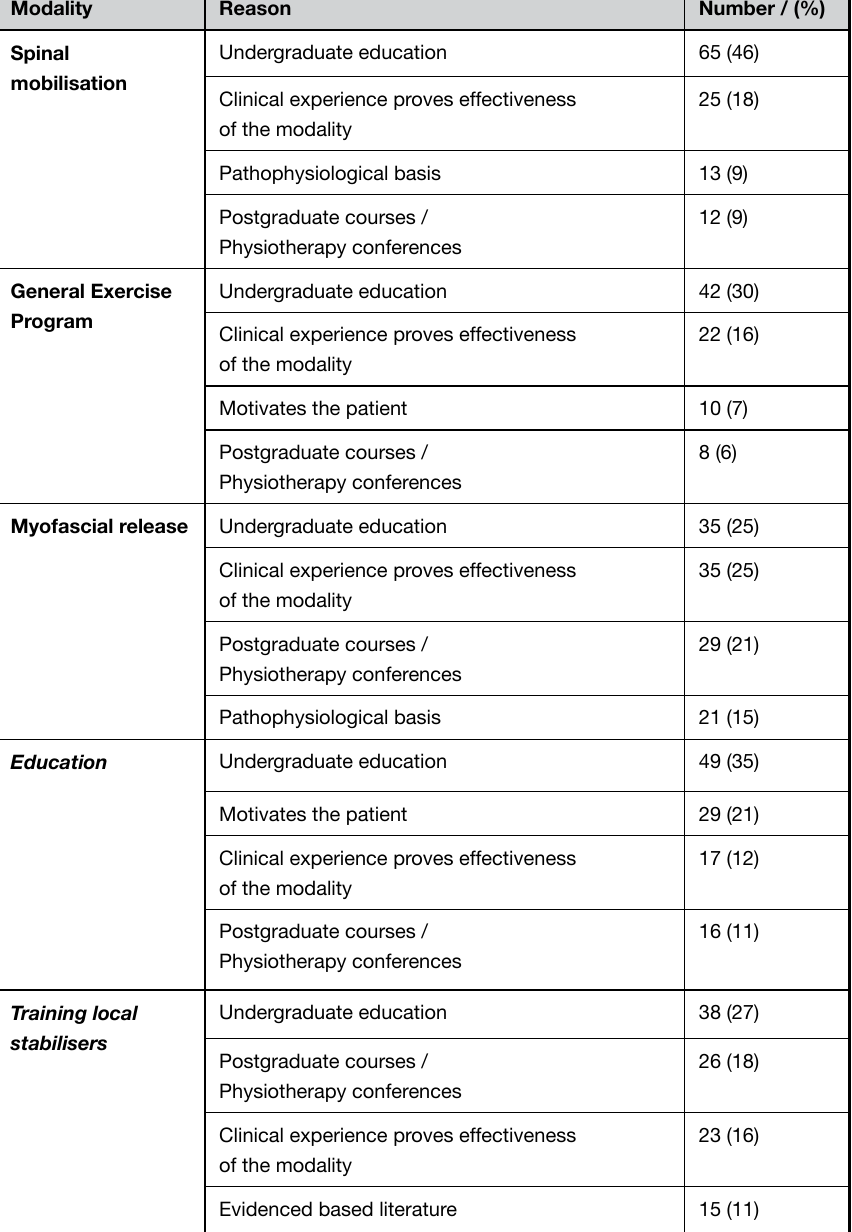
Table 2: The most frequently selected Reasons for the chosen modalities (n=141)